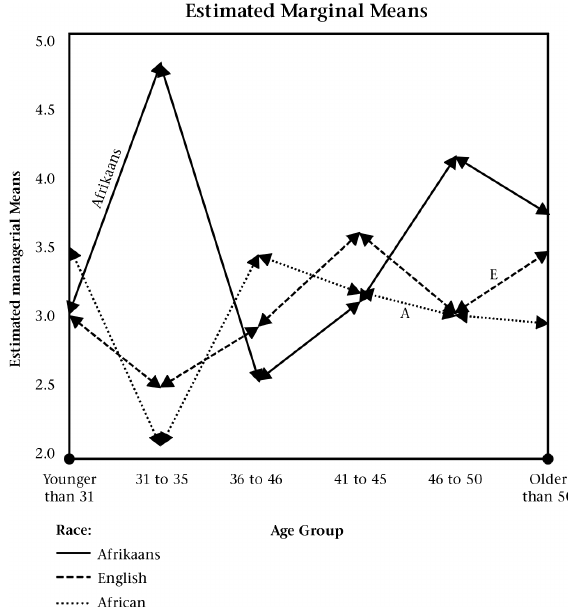
Figure 10: Biographical variables: Age x Home language as predictors of the perceptions of black economic